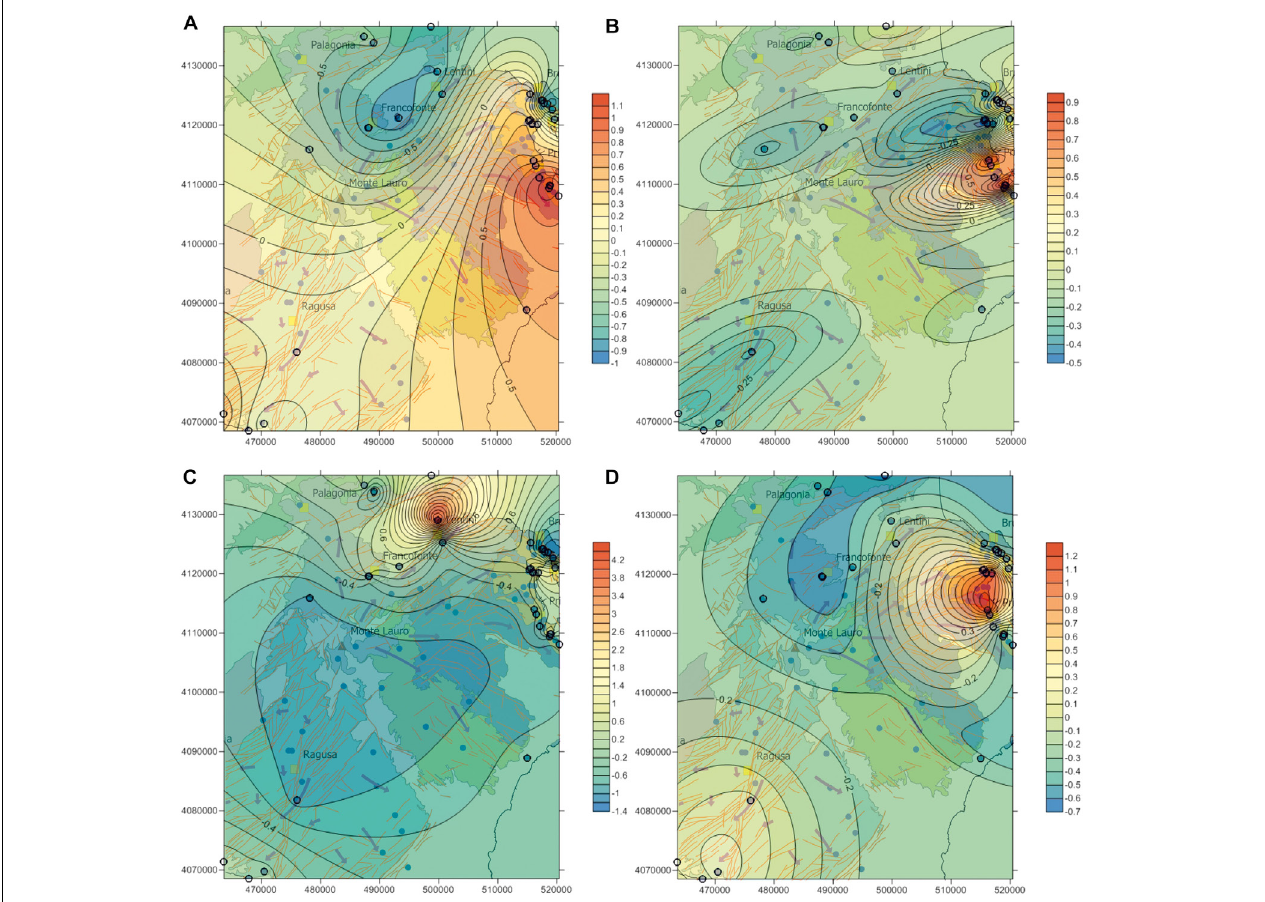
FIGURE 7 | Maps of the spatial distribution of the scores of first four factors extracted from the PCA. (A) factor 1, indicative of water pollution from human factors; (B) factor 2, indicative of hydrothermal conditions in the studied aquifers; (C) factor 3, likely related with hydrothermal conditions in the studied groundwaters; (D) factor 4, that indicates areas affected by release of magmatic gasses with almost no heat carried by them. The base maps are extrapolated from the map in Figure 1 .